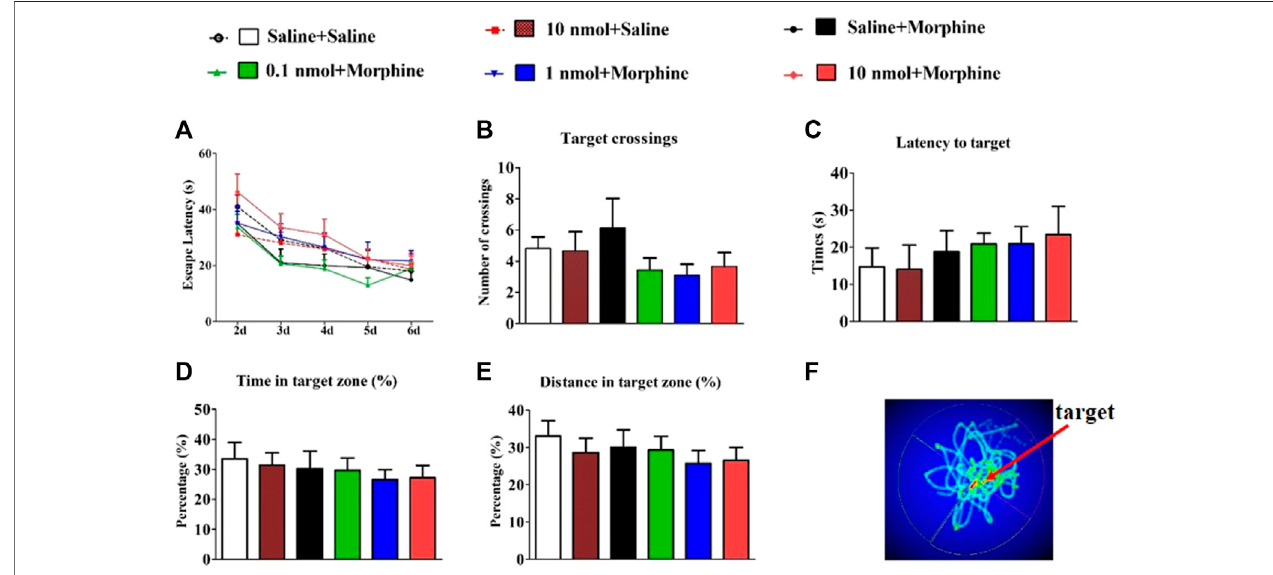
FIGURE 6 | Effects of α -conotoxin TxIB in Morris water maze test. Data are presented as the mean ± SEM, n (cid:1) 8 – 10. (A) The escape latency from water onto the platform during the hidden platform test. Two-way RM ANOVA for the escape latency: interaction, F 20,192 (cid:1) 0.65, p (cid:1) 0.87; time, F 4,192 (cid:1) 24.83, p < 0.001; the different dosesgroup,F 5,192 (cid:1) 1.22, p (cid:1) 0.31.Spatialmemorywasassessedinaprobetrialwithrespectto: (B) targetcrossings, (C) latencytotarget, (D) percentoftimeintarget quadrant, (E) percent ofdistancein target quadrant. There wasno signi fi cance among the sixgroups. ANOVA for spatial memory in a probe trial: target crossings, F 5,47 (cid:1) 1.22, p (cid:1) 1.02; latency to target, F 5,47 (cid:1) 0.43, p (cid:1) 0.82; percent of time in target quadrant, F 5,47 (cid:1) 0.33, p (cid:1) 0.89; percent of distance in target quadrant, F 5,47 (cid:1) 0.50, p (cid:1) 0.78. (F) Thermal image of mouse trajectory in Morris water maze probe trial. Mice to explore the nearby former platform position signi fi cantly more than elsewhere.